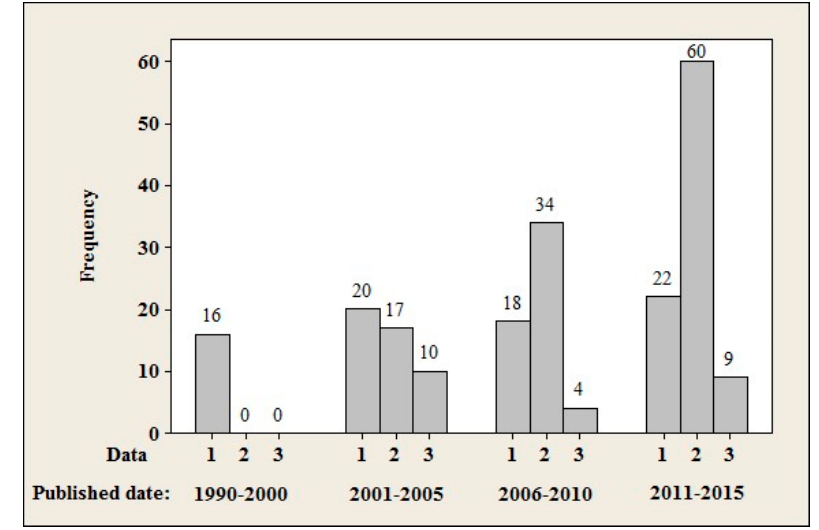
Figure 2. Summary of remotely sensed data (1: passive; 2: active; 3: both passive and active data) used in ITCD and related literature by publication date ( N = 210).